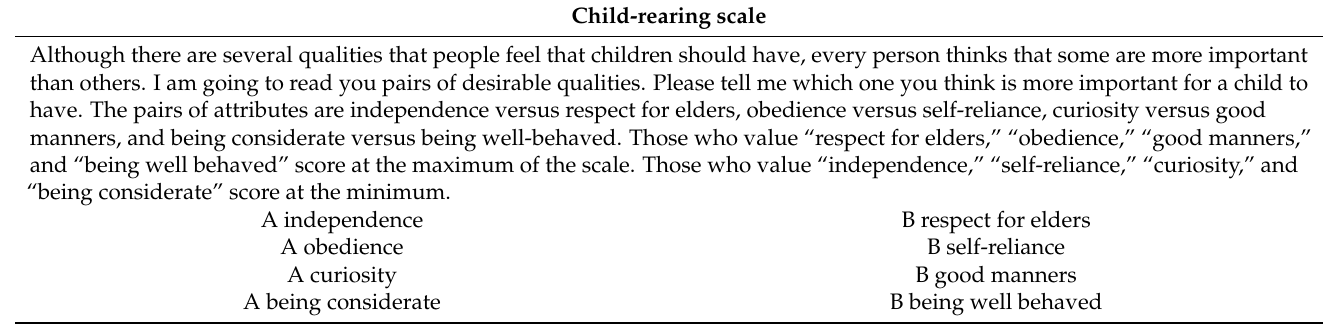
Table A6. Questionnaire B. Questionnaire B Child-rearing